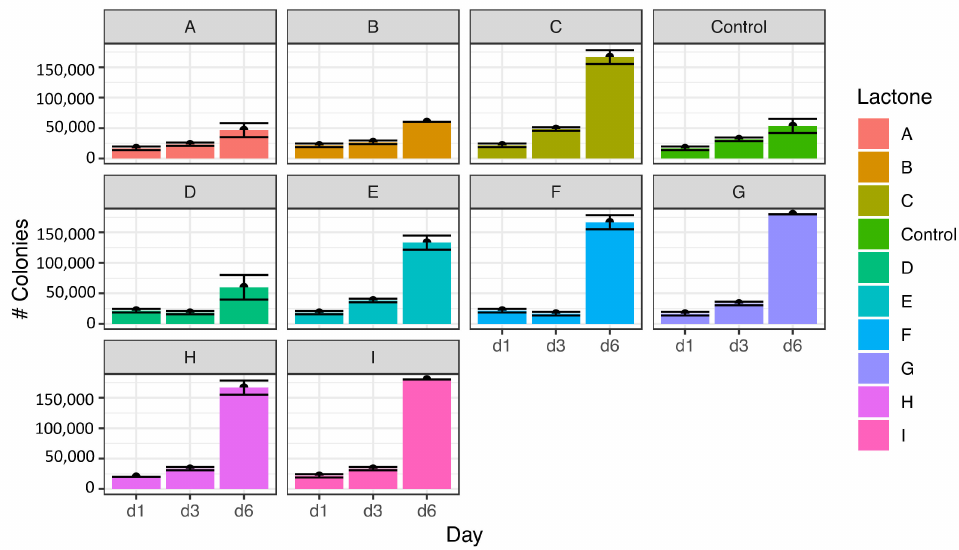
Figure 3. Induction of the formation of Microcystis aeruginosa colonies exposed to the nine lactones for six days. Compounds: N-(3-oxodecanoyl) ( A ), N-(3-oxododecanoyl) ( B ), N-hexanoyl ( C ), de- canoyl ( D ), heptanoyl ( E ), N-dodecanoyl ( F ), N-octanoyl ( G ), N-(3-oxooctanoyl) ( H ), N-butyryl ( I ). Lactones C, F, G, H, and I, and to a lesser degree E, were potent colony inducer compounds with values close to 400% or more, but lactones A, B and were practically inactive. Whiskers are standard deviations, and bars are mean values among